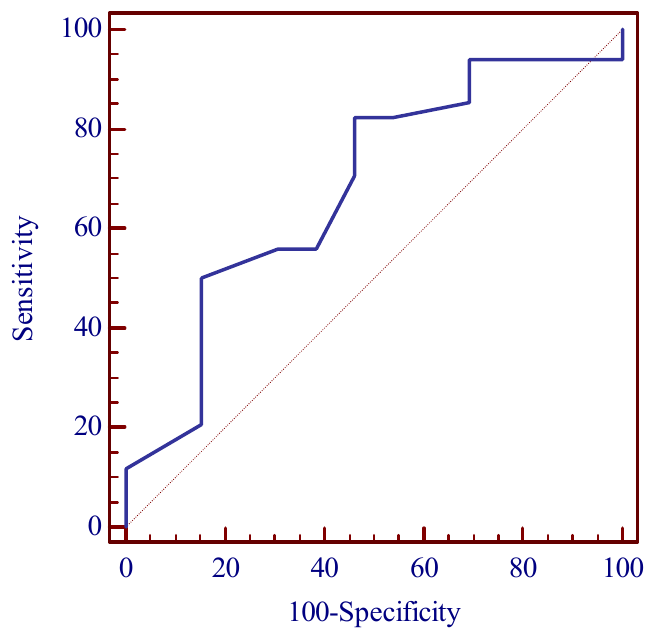
Figure 1. Respondent ROC curve for predicting the threshold age.